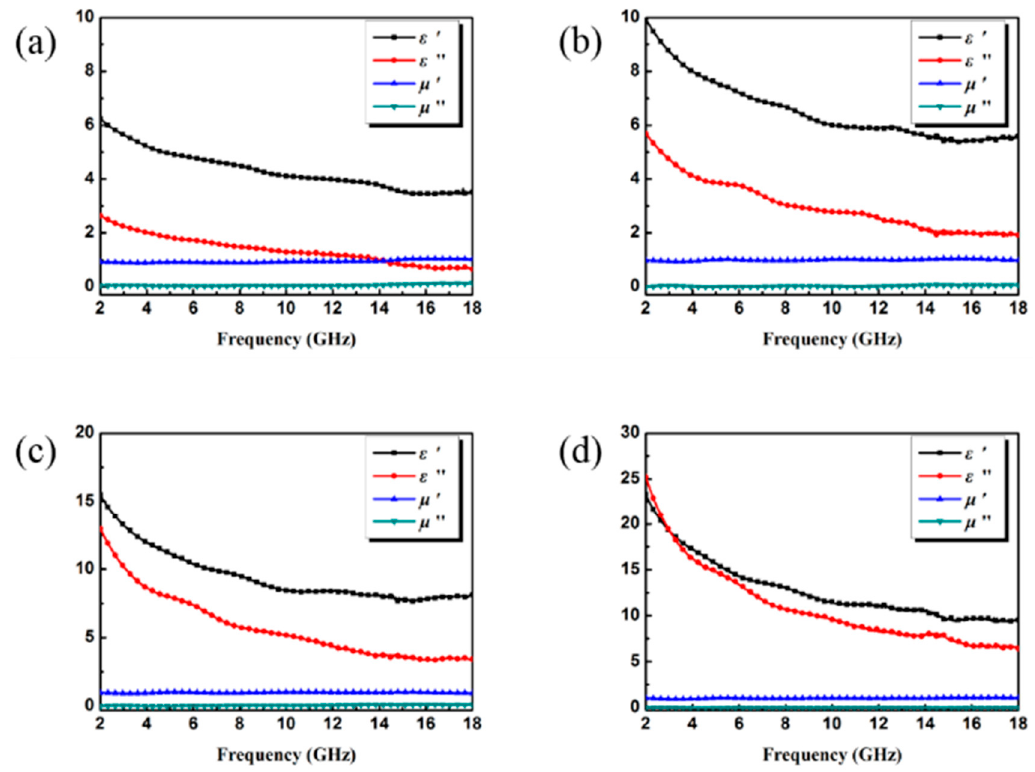
Figure 5. Complex permittivity and permeability of rGO/CuS/PPy with the filler loading of 5 wt.% ( a ), 10 wt.% ( b ), 15 wt.% ( c ), and 20 wt.% ( d ).